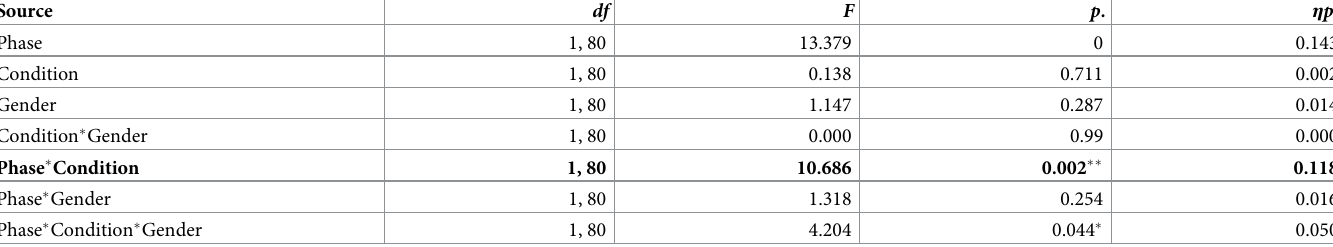
Table 7. Tabulated values for mixed ANOVA with phase (pre- versus post- manipulation preference for muscularity scores) as the repeated measures variable, and condition (condition 5 versus condition 6) and gender (male versus female) as between-participant factors. Critical tests of our hypotheses are shown in bold. Source df F p . η p 2 Phase